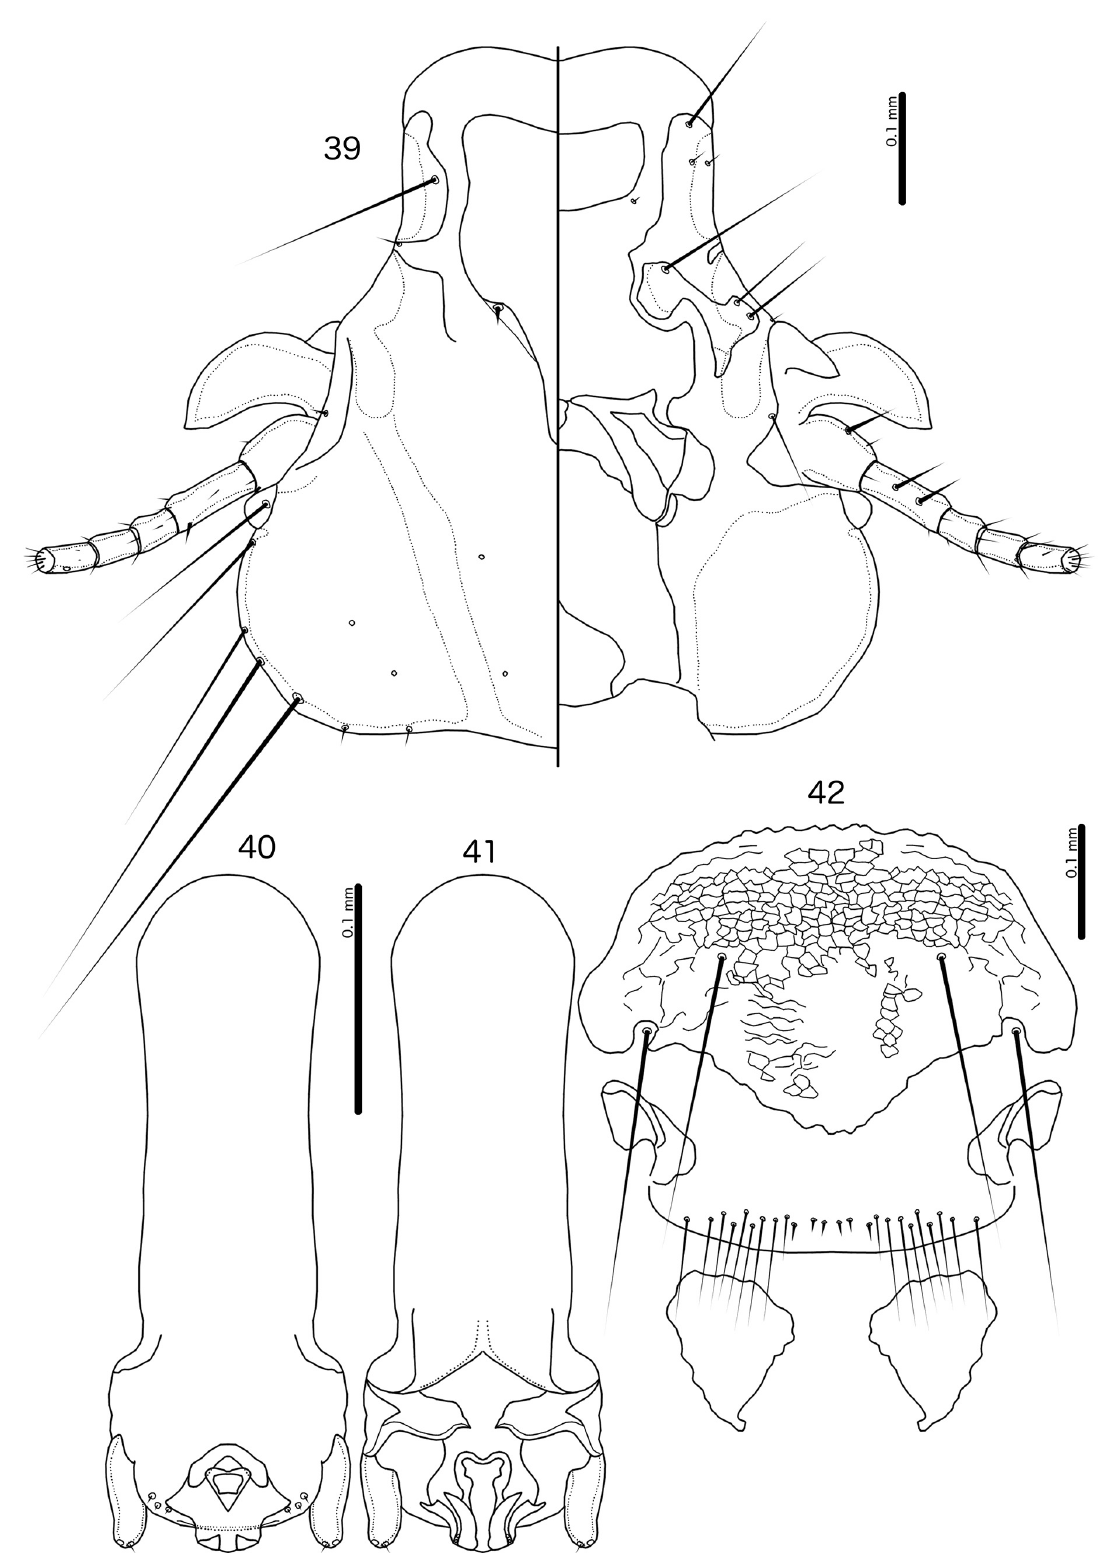
Figs 39–42. Philopterus coriaceus sp. nov. ex Molothrus oryzivorus oryzivorus (Gmelin, 1788). 39 . Male head, dorsal and ventral views. 40 . Male genitalia, dorsal view. 41 . Male genitalia, ventral view. 42 . Female subgenital plate, vulval margin, and subvulval plates, ventral